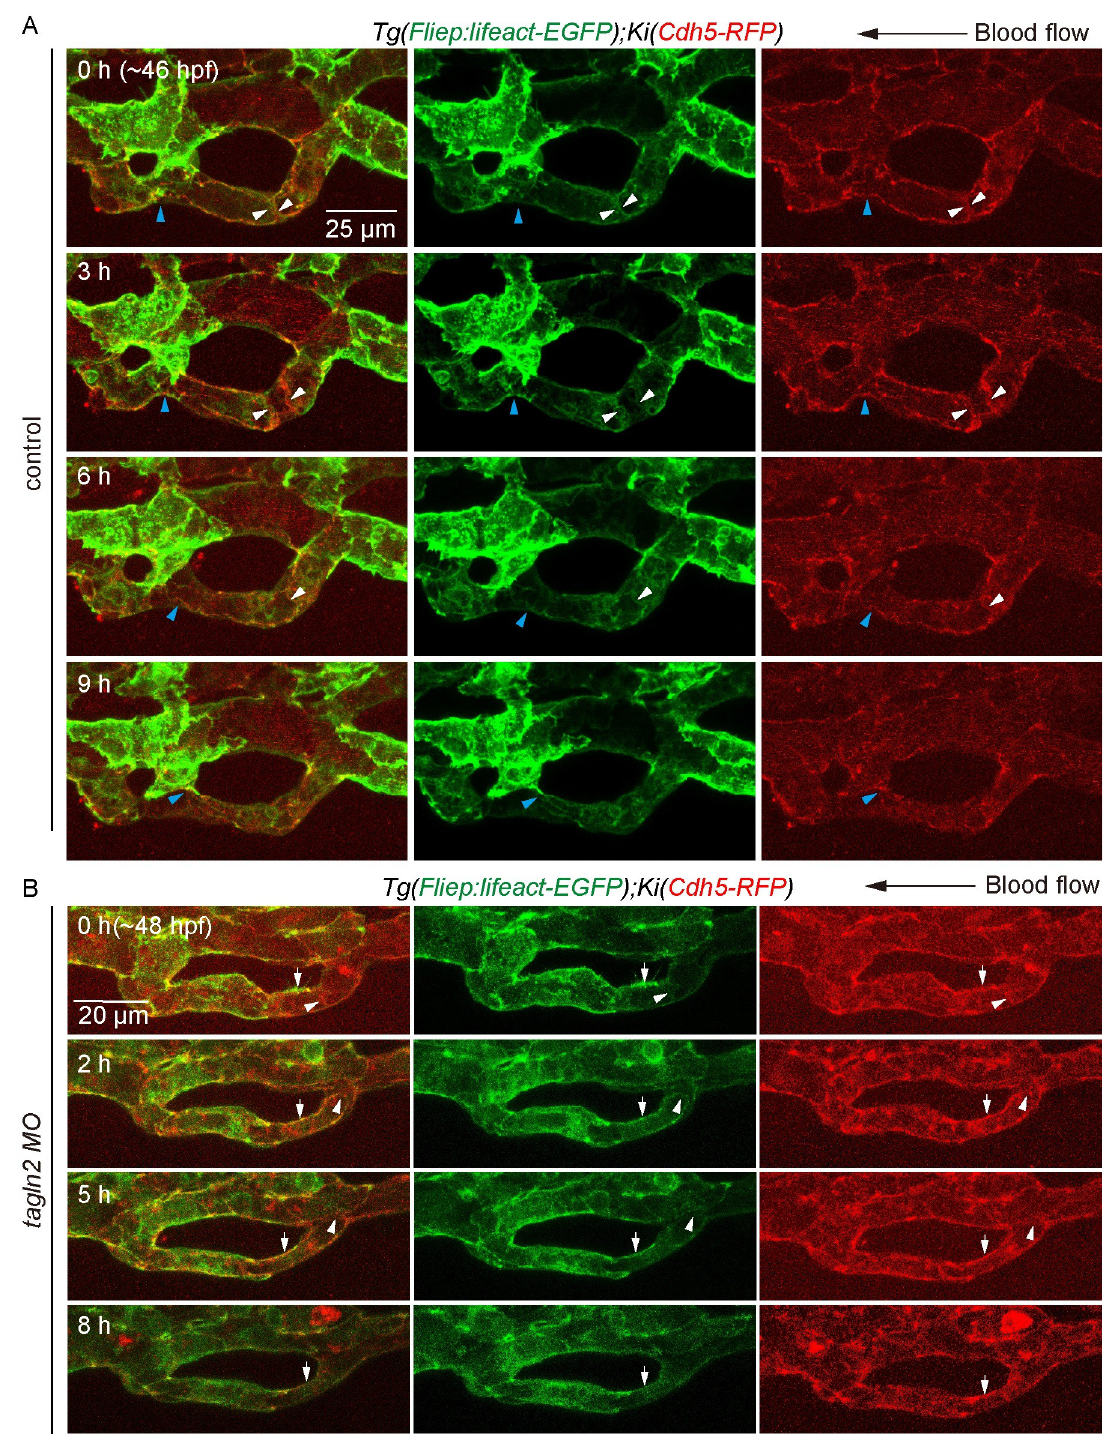
Fig 8. Knockdown of tagln2 impairs junction remodeling and rearrangement of F-actin cytoskeleton in CV pruning. (A) and (B) Time-lapse live imaging of junction remodeling and actin cytoskeleton dynamics in CV prunig in Tg(Fliep : Lifeact-EGFP);KI (cdh5-mRFP) embryos. (A) Control embryo shows a detachment of junction (blue arrowheads) and an opposite direction of junction movement (white arrowheads) as multicellular tube became stenosis. F-actin forms at cdh5-positive junction (white and blue arrowheads), and undergoes a similar rearrangement as cdh5-positve junctions. Seven vascular loops are taken time-lapse live imaging at the stage of multicellular tube. Scale bar: 25 μ m. (B) In tagln2 morphant, cdh5-positive junction moves to the right and connected